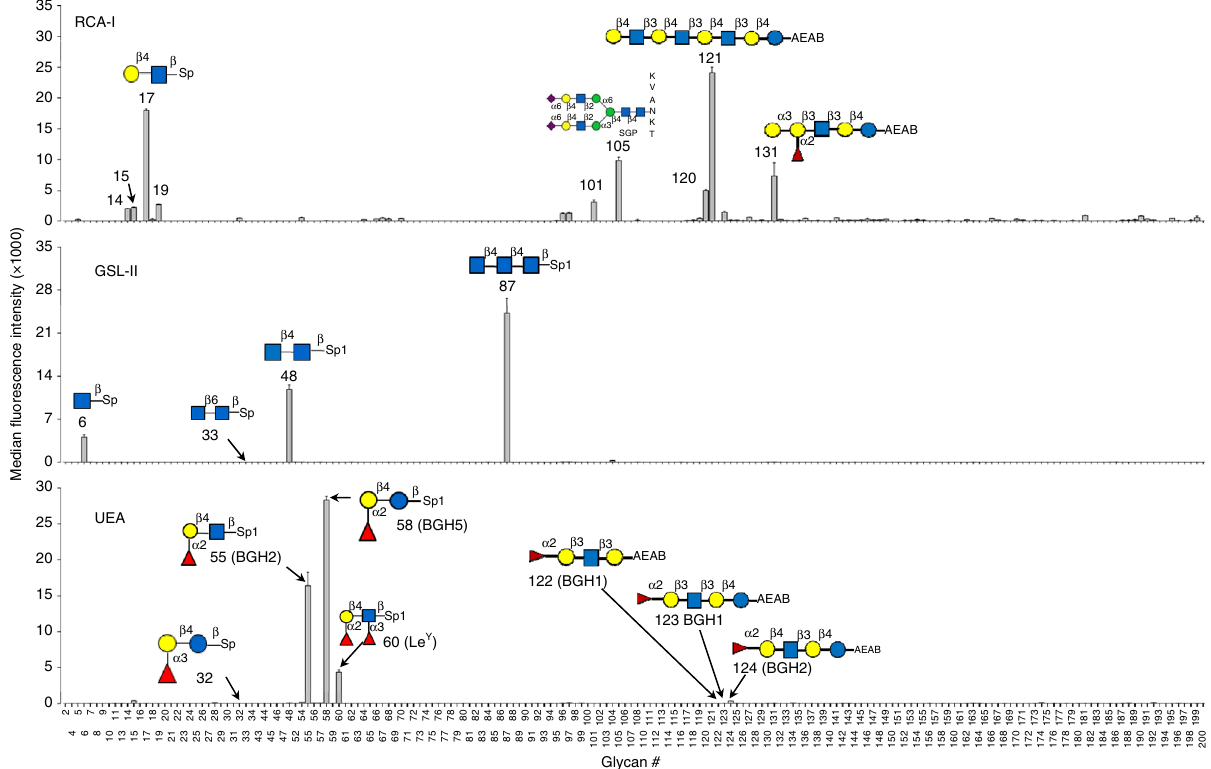
Fig. 2 MGBA data using lectin as detection reagents. Bar charts show median fl uorescence intensity (MFI) (on y -axis) for each of the 184 glycans by their order of glycan ID (on x -axis). Data for three representative lectins are shown and data for all other lectins are in Supplementary Figure 3. The data are presented as mean+standard deviation of two replicates; each experiment was repeated three